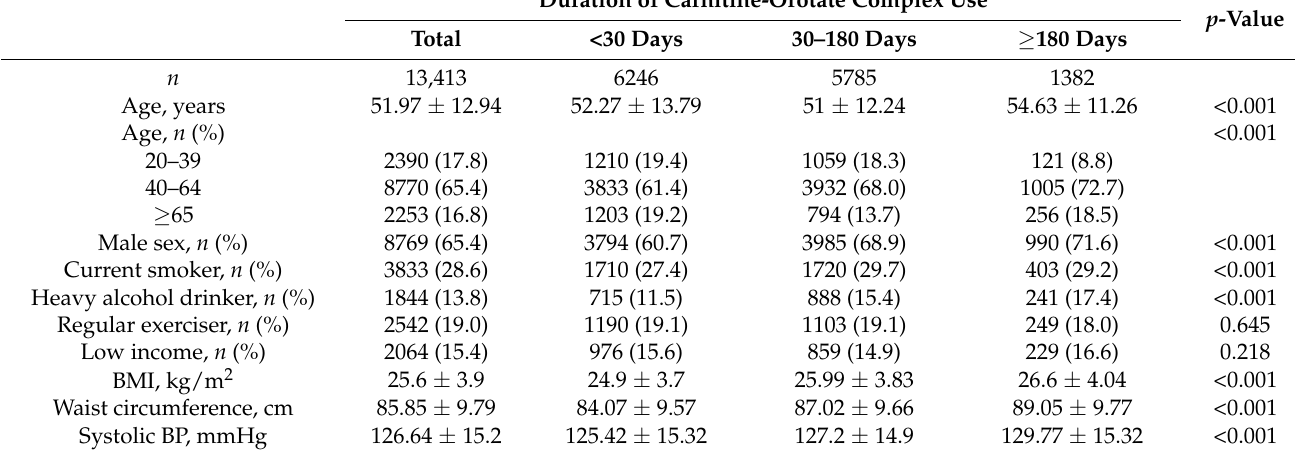
Table 1. Baseline characteristics of participants using carnitine-orotate complex according to duration of